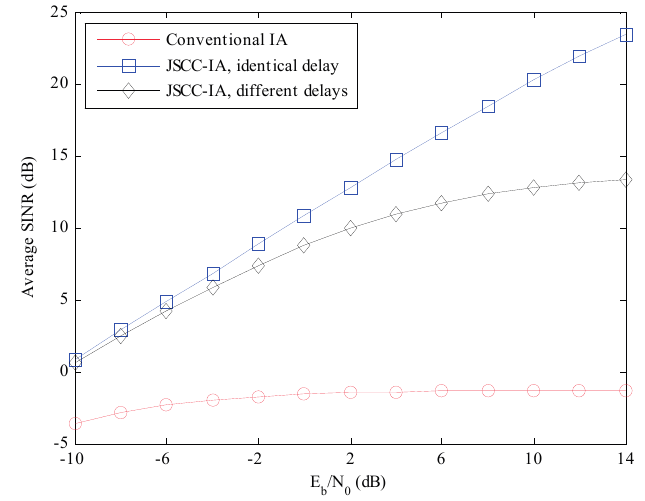
Figure 10. The average received SINR of the conventional IA scheme and the JSCC-IA schemes with identical/different propagation delays in the (6 × 6, 2) 18 symmetric